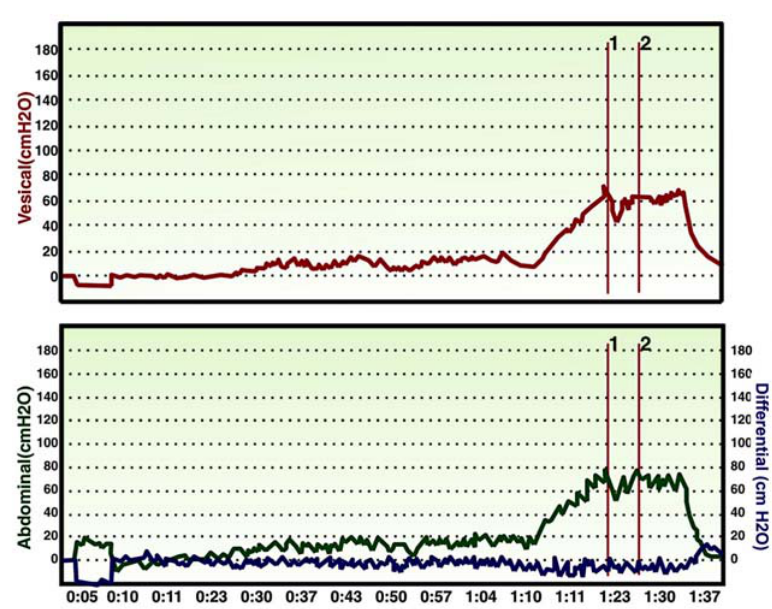
Figure 5 – Pressure curves of intestinal light (P1 - red ranging), channel (P2 - green ranging) and gradient pressure (P3 - purple ranging) showing parallelism in the lack of valve; thereby validating P2 record.